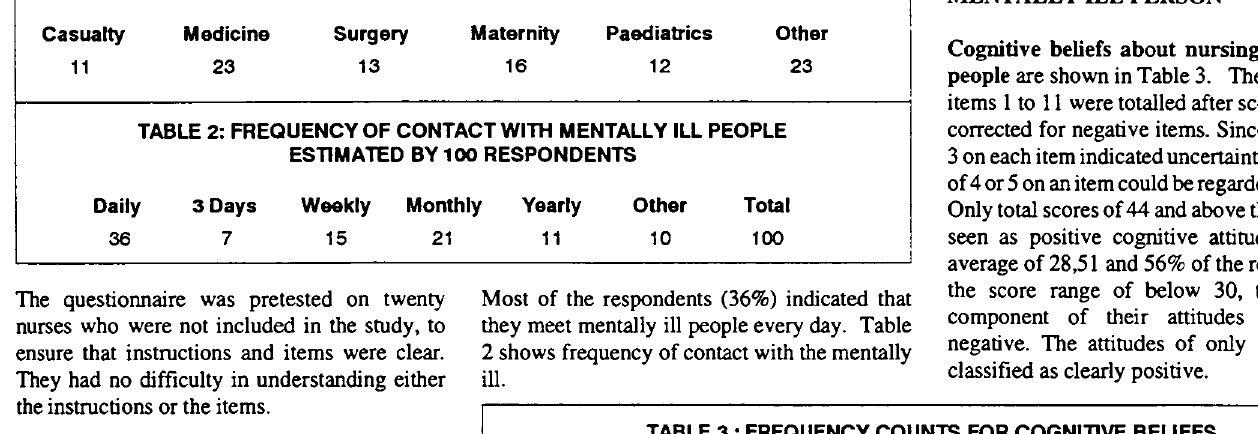
TABLE 4 : FREQUENCY COUNTS FOR BEHAVIORAL BELIEFS (N=